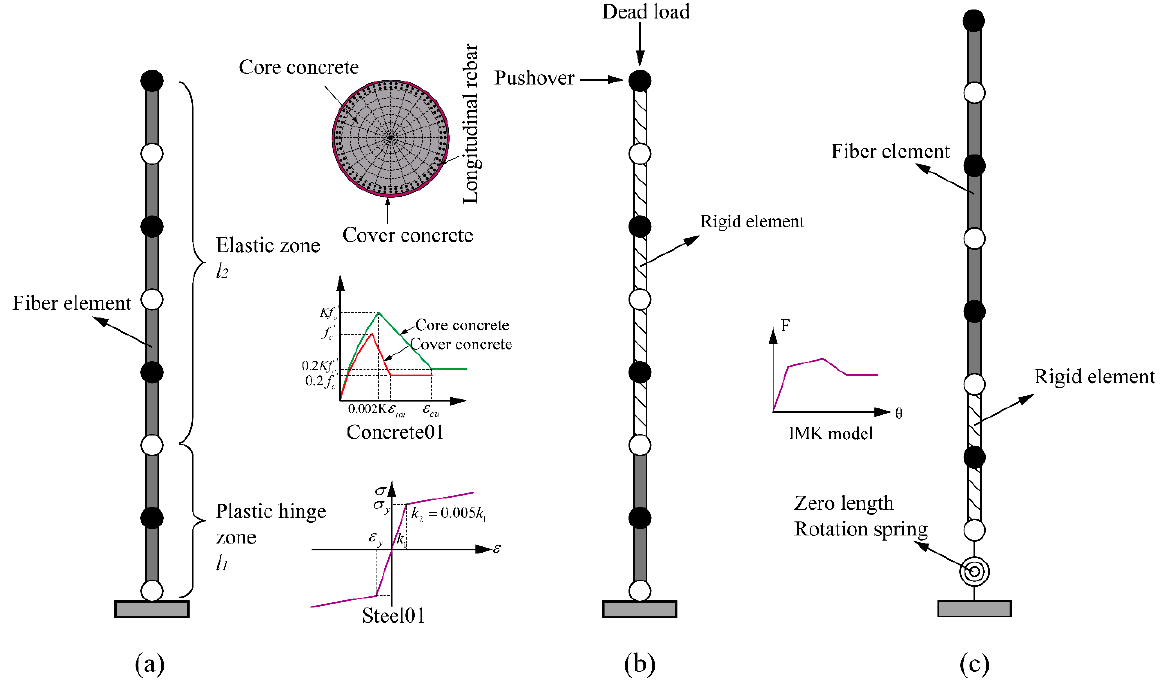
Figure 4. Procedure for determining the backbone curve parameters: ( a ) the fiber-based column model, ( b ) conducting monotonic pushover analysis to determine the parameters for the zero-length rotation spring, and ( c ) the final lumped plasticity column model.